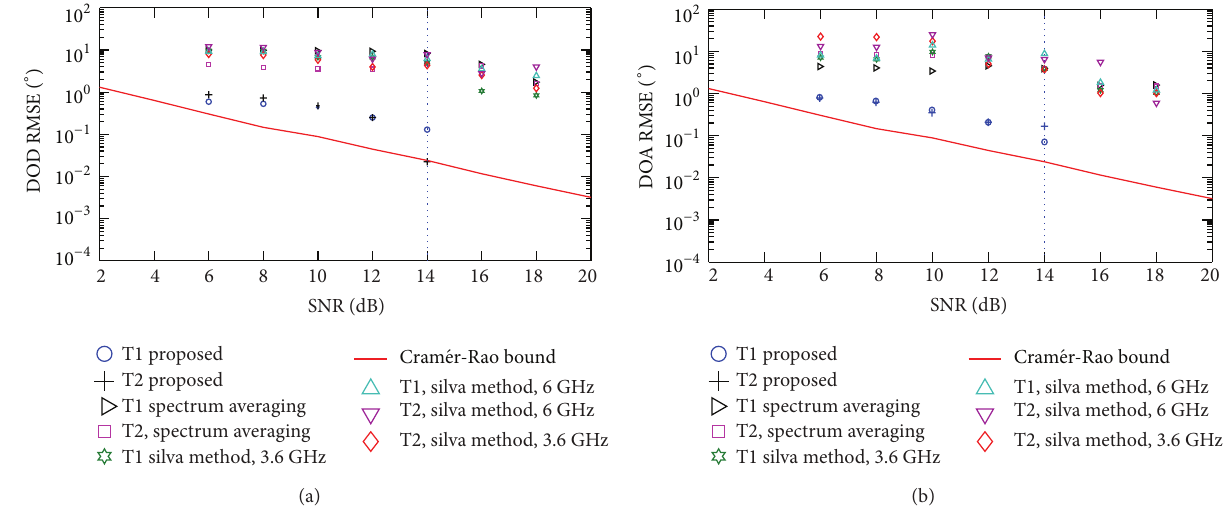
Figure 14: RMSE performance of the proposed scheme: (a) DOD and (b) DOA.